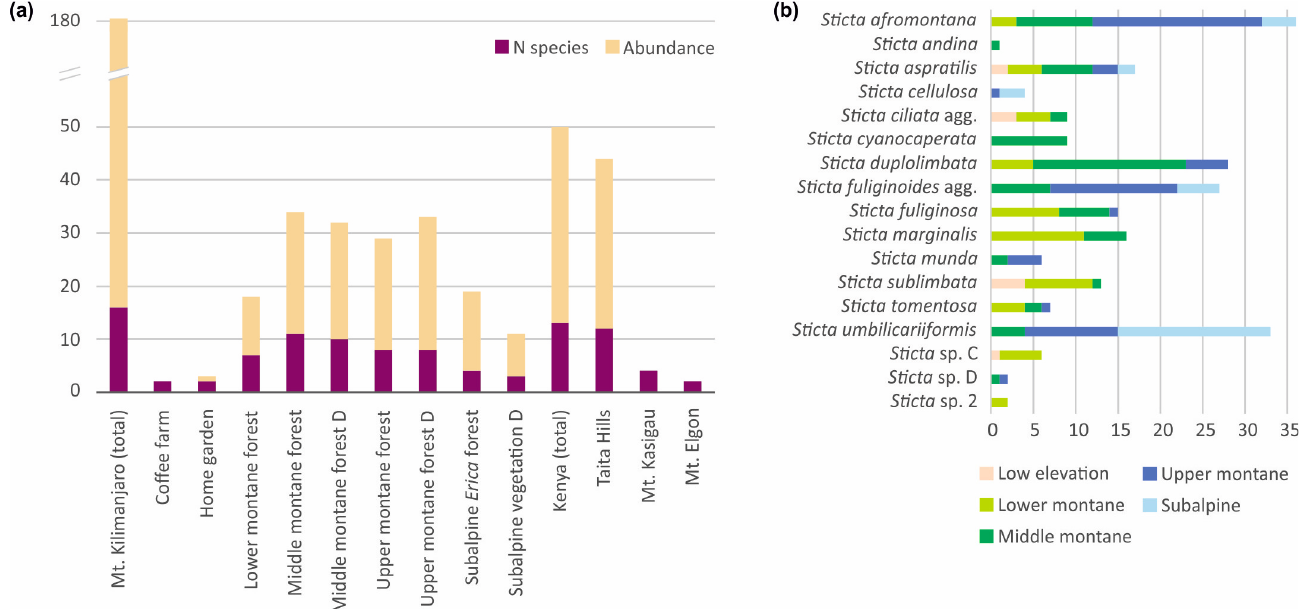
Figure 14. Diversity and abundance of the genus Sticta in the study region. ( a ) Number of species (dark red) and abundance (light orange) in the different habitats and locations. D = disturbed. ( b ) The abundance of the Sticta species in different elevation zones and habitat types. Low elevation habitats: dry woodland on Mt. Kasigau, the Maktau Hill, Shomoto Hill in the Taita Hills, and coffee farm and home garden habitats on Mt. Kilimanjaro; Lower montane forests: most evergreen forests in the Taita Hills and on Mt. Kasigau, and lower montane forest on Mt. Kilimanjaro. Middle mon- tane forests: middle montane forests on Mt. Kilimanjaro and on Vuria Mountain in the Taita Hills. Upper montane forest: such forests on Mt. Kilimanjaro. Subalpine: subalpine habitats on Mt. Kili- manjaro and Mt. Elgon. Sticta ciliata agg. includes specimens of S. ciliata and Sticta sp. B; Sticta fulig- inoides agg. includes specimens of S. fuliginoides and Sticta sp. A.